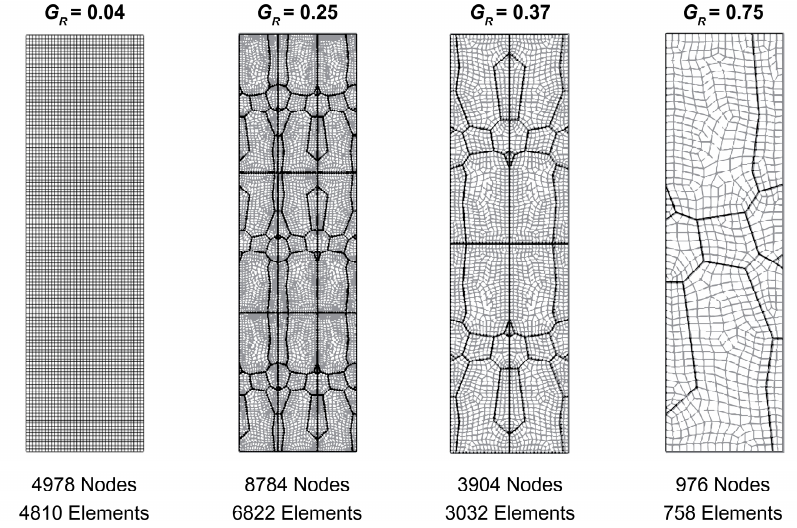
Figure 14. The meshing elements and nodes of the studied grain sizes.